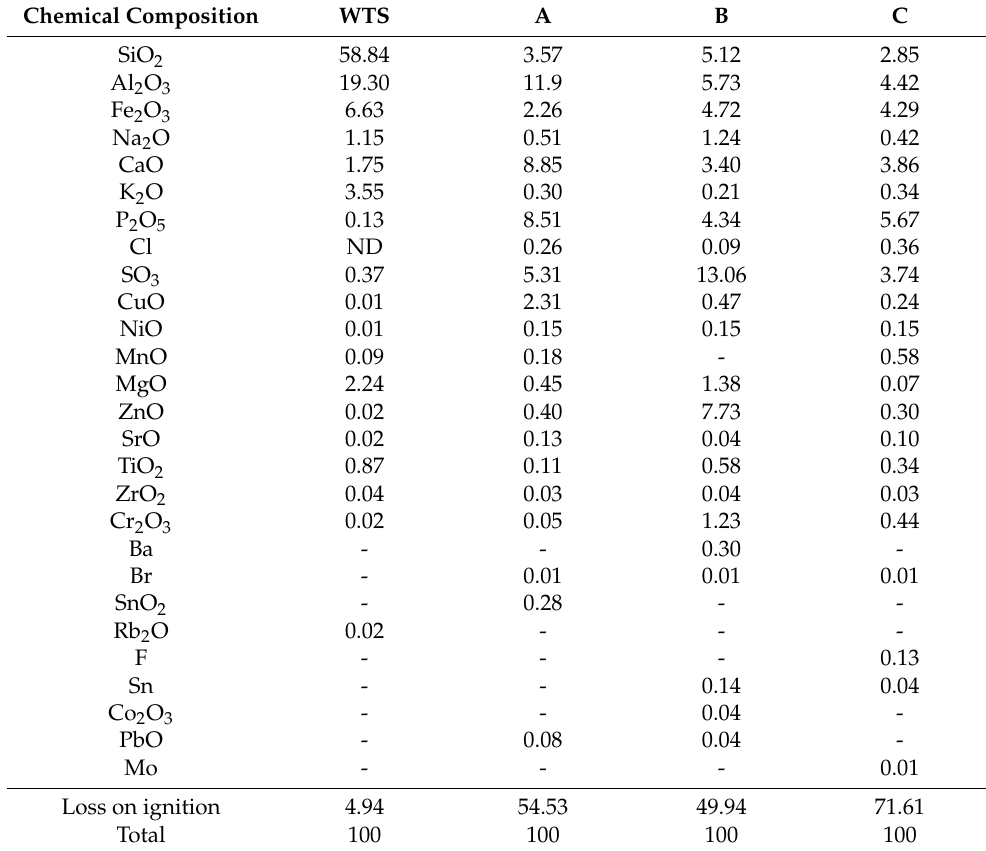
Table 2. Chemical composition of sludge samples (% by weight). Chemical